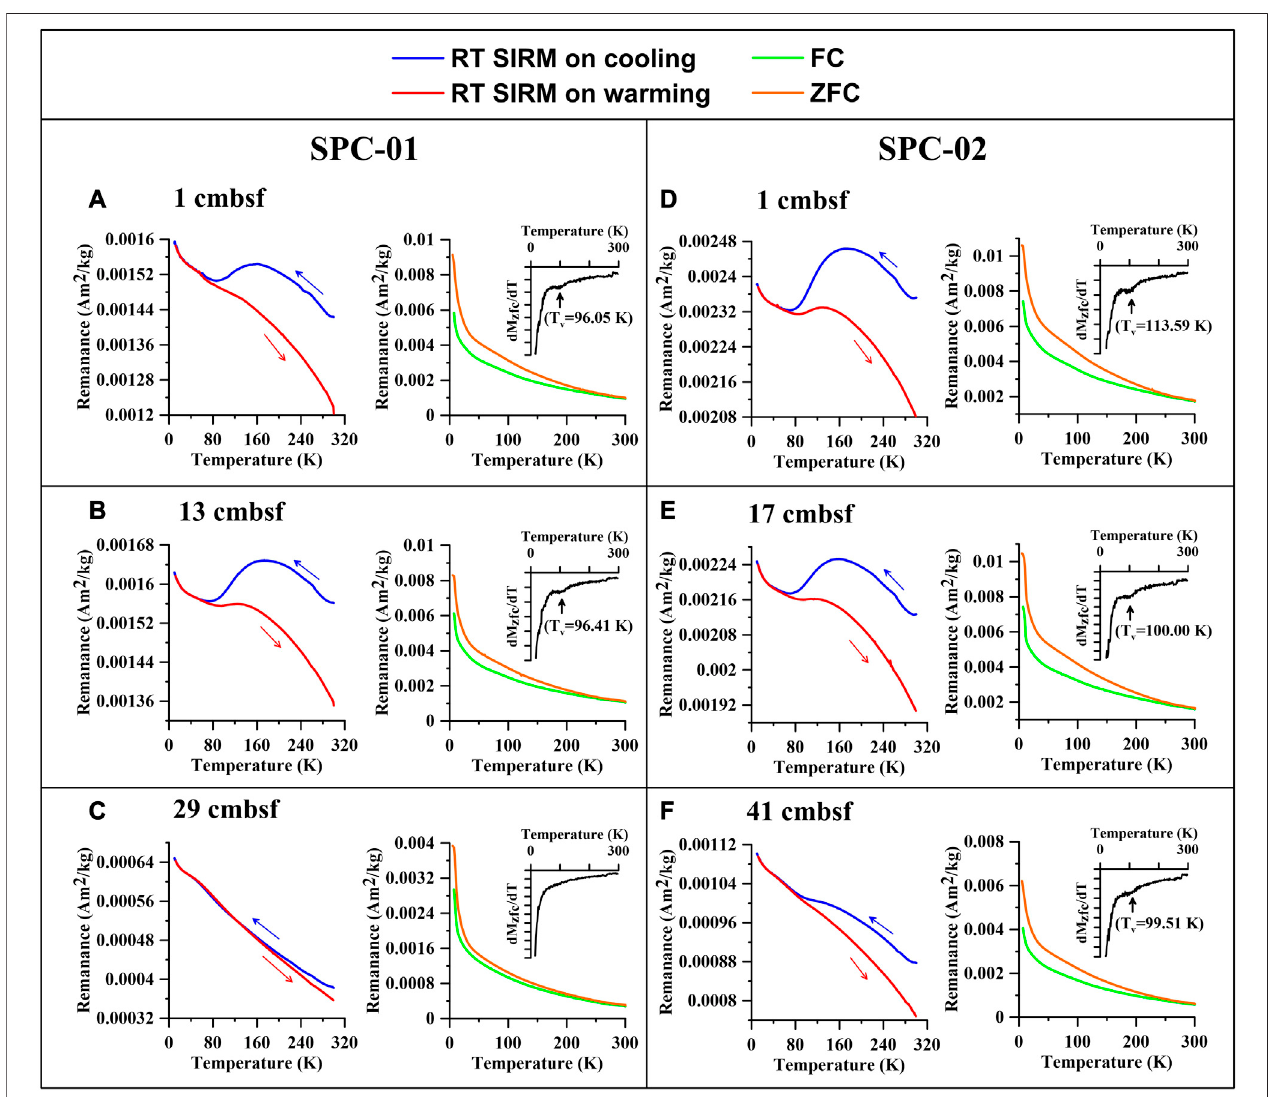
FIGURE 5 | Low-temperature magnetization curves for selected representative samples from the two spade cores (A – C) : SPC-01 and (D – F) : SPC-02. FC, fi eld- cooled; RTSIRM, saturation isothermal remanent magnetization at room temperature; ZFC, zero fi eld-cooled. The corresponding values of Verwey transition (Tv) are placed near the fi rst derivative of magnetization